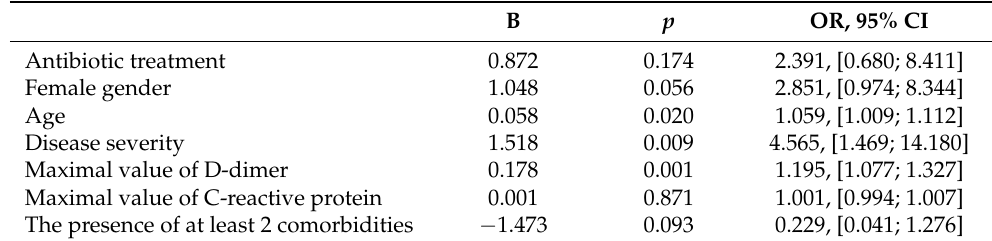
Table 5. Multivariate analysis in patients without a proven Clostridioides infection—adjusted for age, gender, severity, inflammatory markers and the presence of at least 2